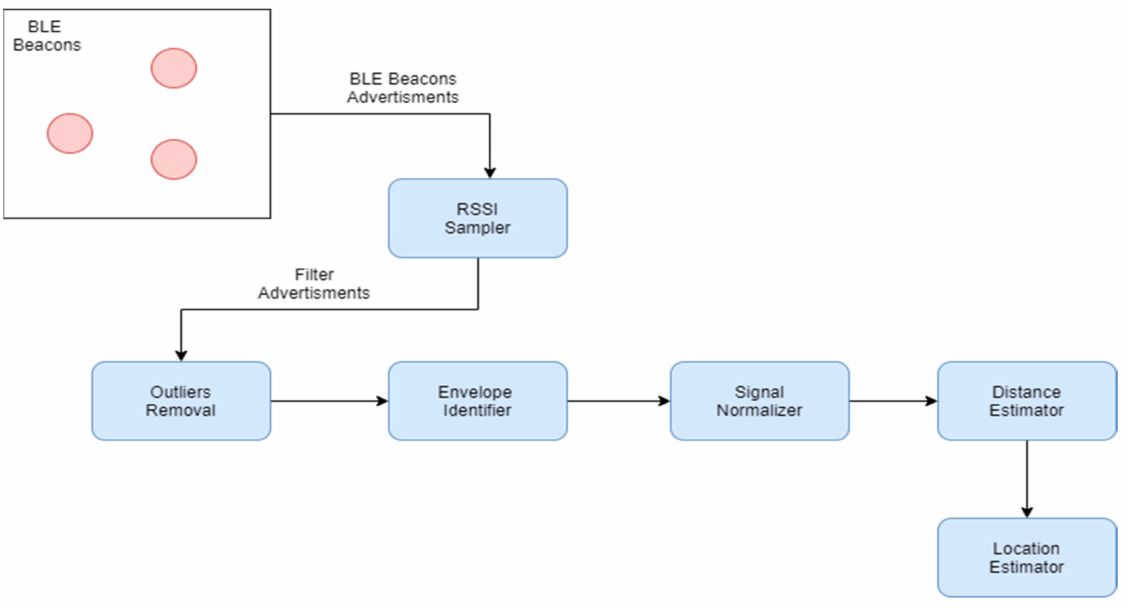
Figure 3. Range-based localization